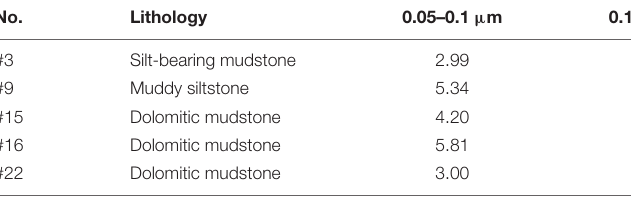
TABLE A3 | NMR analysis results.